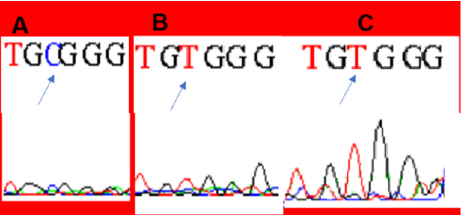
Figure 3. Promoter hypomethylation seen in bisulfate-treated DNA samples from cells treated with ( B ) 35 and ( C ) 40 µM tamoxifen in comparison with untreated control cells ( A ). Unmethyl-